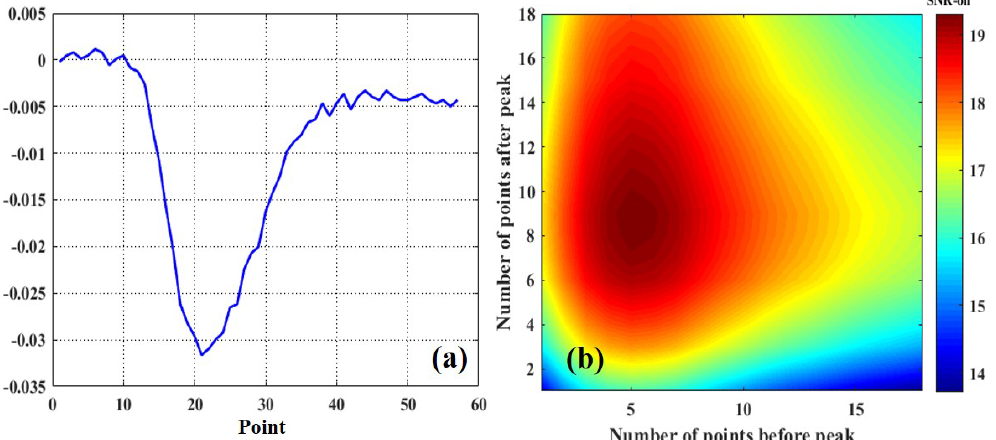
Figure 8. (a) Online wavelength echo pulse signal in land area. (b) The change of the SNR of the echo pulse signal in the land area with the number of selected pulse points.